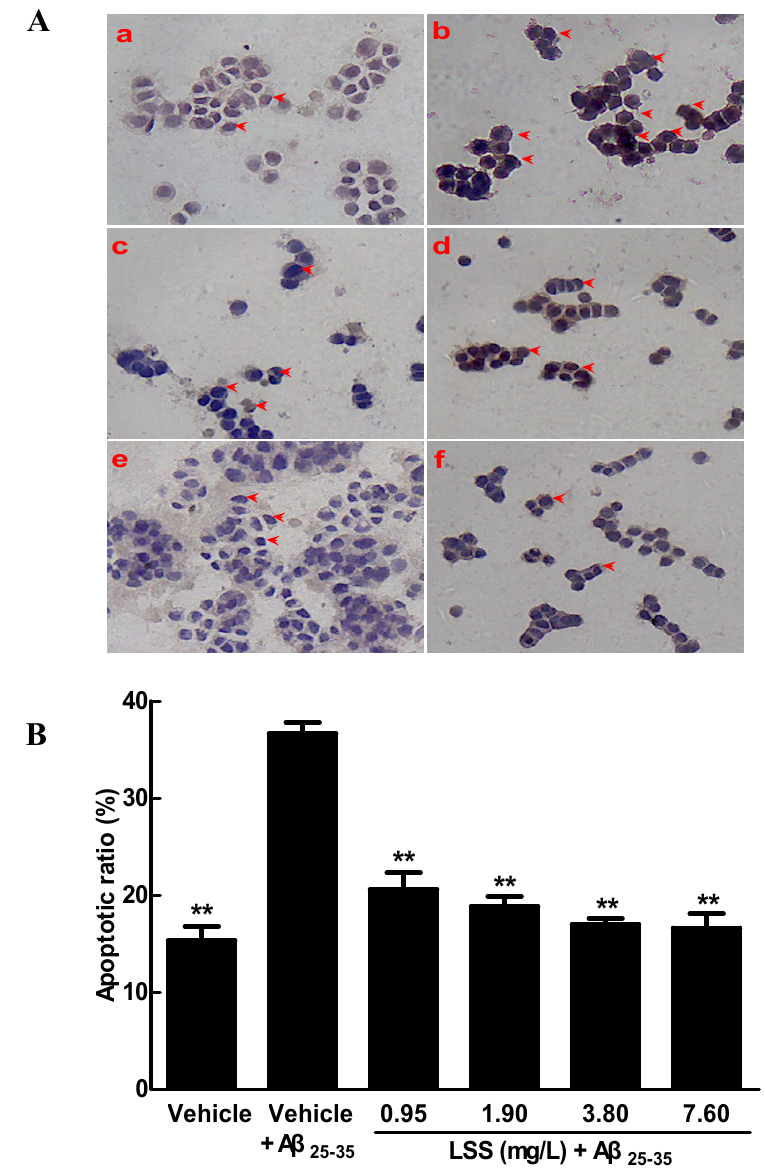
Figure 3. Effect of LSS on apoptosis ( A ) and apoptotic ratio ( B ) induced by A β 25 ‐ 35 (20 μ mol/L) in PC12 cells with TUNEL analysis (×400). ( Aa ) Cells were treated with medium for 13 h without A β 25 ‐ 35 ; ( Ab ) cells were treated with medium for 1 h and followed by A β 25 ‐ 35 for 12 h; ( Ac ) cells were treated with LSS 0.95 mg/L for 1 h and followed by A β 25 ‐ 35 for 12 h; ( Ad ) cells were treated with LSS 1.90 mg/L for 1 h and followed by A β 25 ‐ 35 for 12 h; ( Ae ) cells were treated with LSS 3.80 mg/L for 1 h and followed by A β 25 ‐ 35 for 12 h; ( Af ) cells were treated with LSS 7.60 mg/L for 1 h and followed by A β 25 ‐ 35 for 12 h. The red arrows indicate apoptotic cells; ( B ) Summarized results of apoptotic ratio. The results are representative of at least three independent experiments run in triplicate and expressed as mean ± SD. ** p < 0.01 vs. the cells treated with vehicle and A β 25 ‐ 35 .